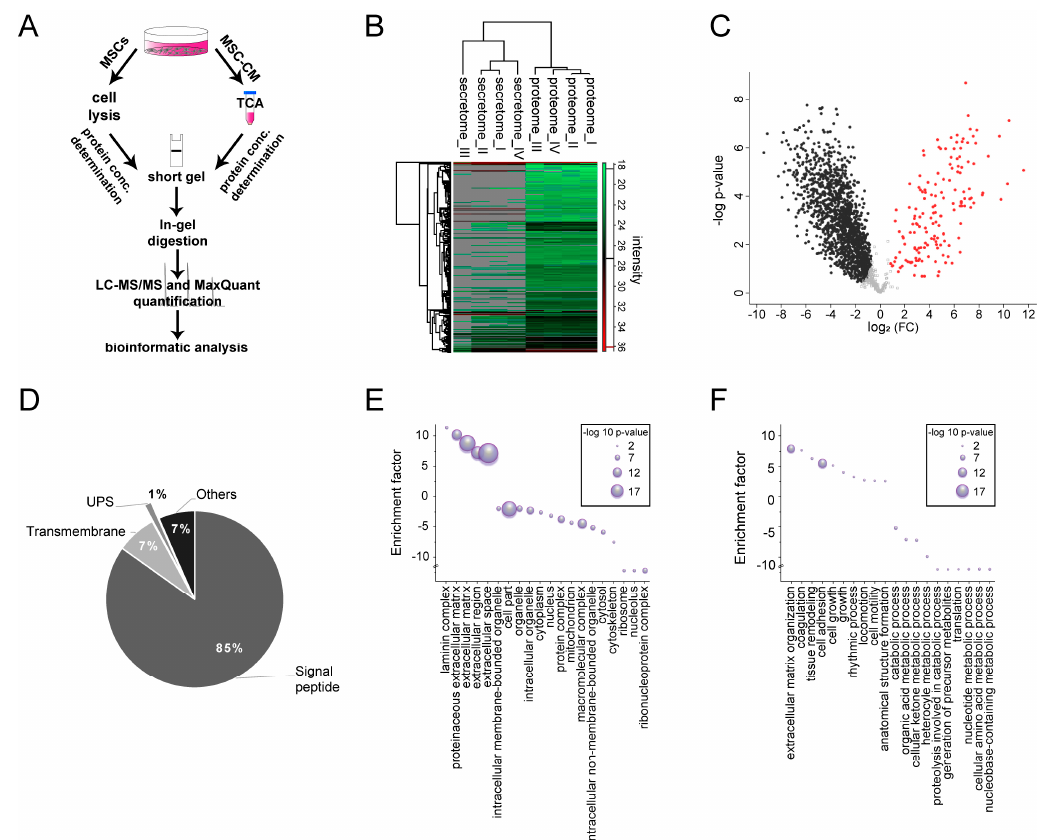
Figure 6. Characterization of the mesenchymal stem cell secretome. ( A ) Workflow for preparation of MSC-derived proteomes and secretomes for quantitative LC–MS/MS analysis. ( B ) Heatmap of proteins quantified in the MSC secretome and proteome revealed a high similarity between the proteome samples that clearly differed from the secretomes (grey = proteins were not identified). ( C ) Volcano plot showing proteins found to be enriched in the MSC-derived secretome (152 secretome-enriched proteins, shown as red dots on right side) and the proteome (left side, black dots). ( D ) Out of the 152 proteins found to be enriched in the secretome, 85% of them were predicted to have a signal peptide, 7% were transmembrane proteins, and 1% were unconventionally secreted (UPS). ( E ) Gene Ontology (GO) enrichment analysis of cellular component revealed that these proteins were associated with extracellular space and matrix localization. ( F ) GO enrichment analysis of biological process revealed an association with extracellular matrix organization and cell adhesion (5% false discovery rate (FDR)). Table 1. Mesenchymal stem cell-secreted proteins associated with oligodendroglial lineage regulation.